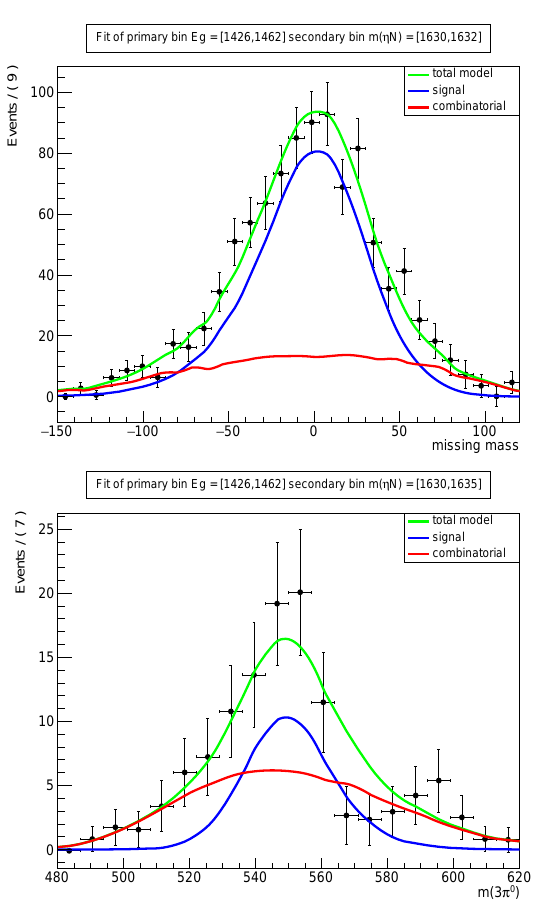
Figure 3. Example unbinned likelihood fits for the same E γ , m ( η N )-bin. Top: Fit of the ηπ 0 -missing mass in the analysis of γ p → ηπ 0 p with η → 2 γ . Bottom: Fit of the m (3 π 0 )-invariant mass in the analysis of γ p → ηπ + n with η → 3 π 0 . Signal and background contributions were obtained from MC